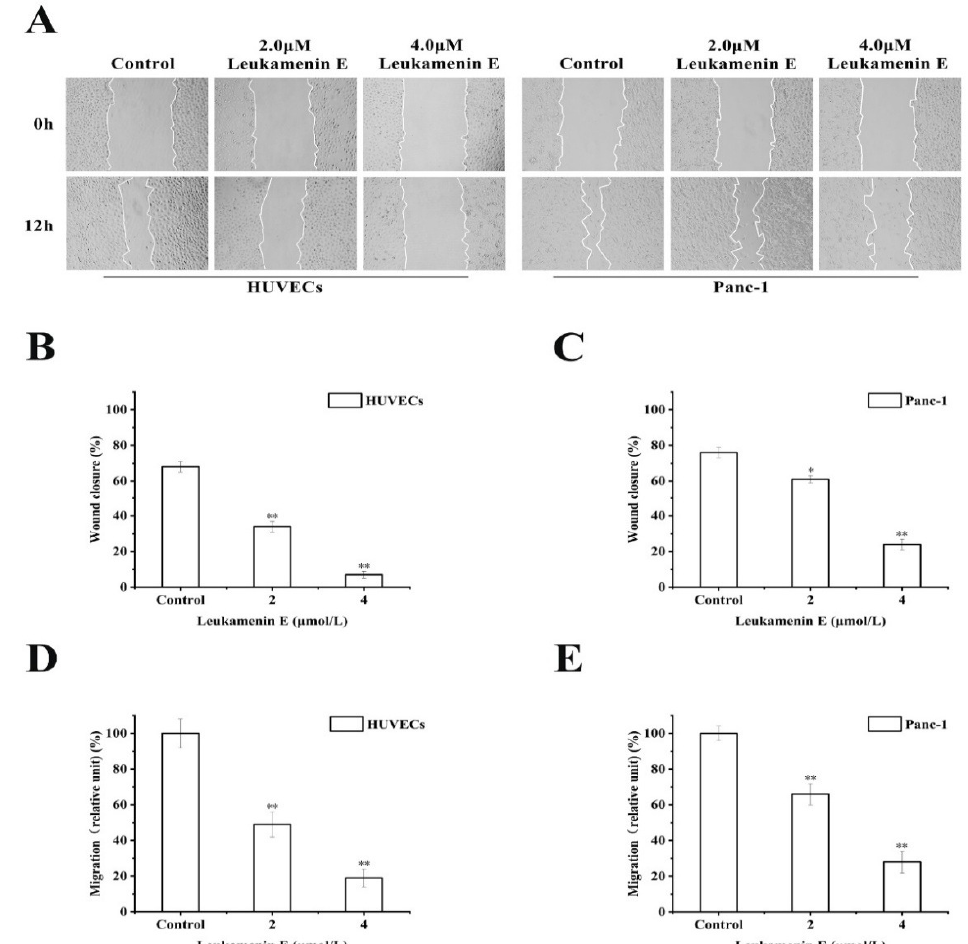
Figure 9. Leukamenin E inhibits migration of HUVECs and Panc-1 cells. ( A ) Scratch wound healing assays were performed to detect the migration of the indicated cells. Images of the scratch wound were captured after 12 h of culture with or without leukamenin E. 100 × multiplication. ( B , C ) Graph quantifying the rate of wound closure in HUVECs and Panc-1 cells. ( D , E ) HUVECs and Panc-1 cells were incubated with 2.0 µ M and 4.0 µ M. The number of cells migrating through size-limited pores was determined by inverted microscopy. The results are presented as means ± SEM. The data shown represent the means ± standard deviation (S.D.) of three independent experiments. *p < 0.05, **p < 0.01, νersus the control group.